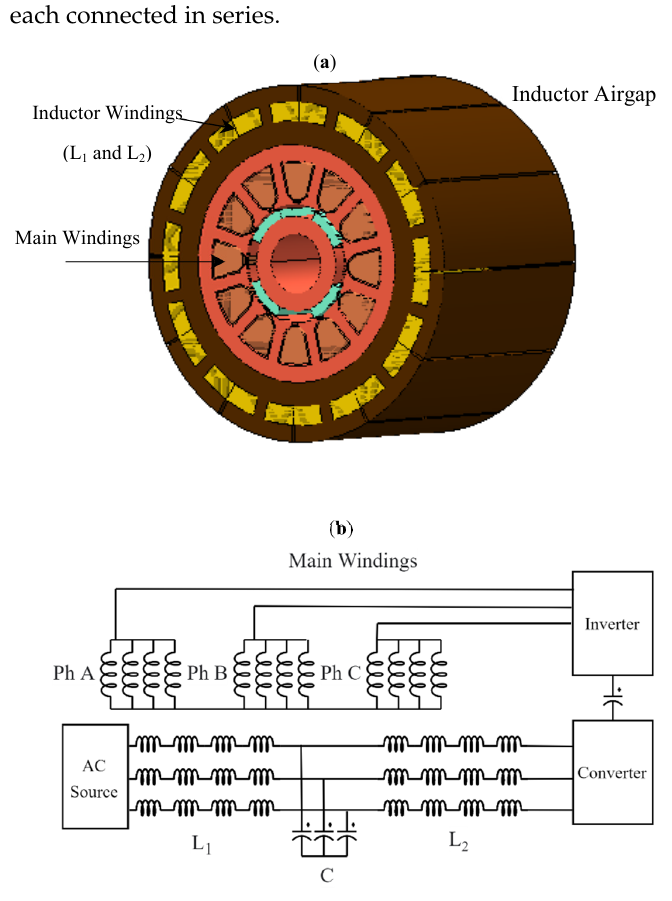
Figure 16. Motor with Integrated Grid LCL Filter ( a ) Axial View of the main motor ( b ) Winding Configuration [28,30].